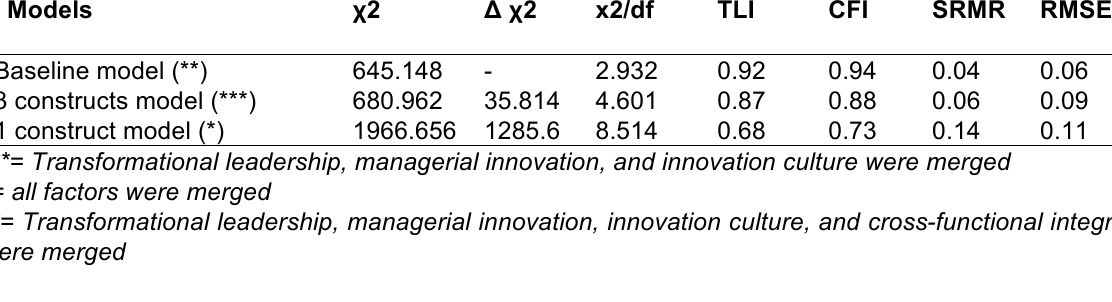
Table 3: CFA results, Comparison of the alternative models